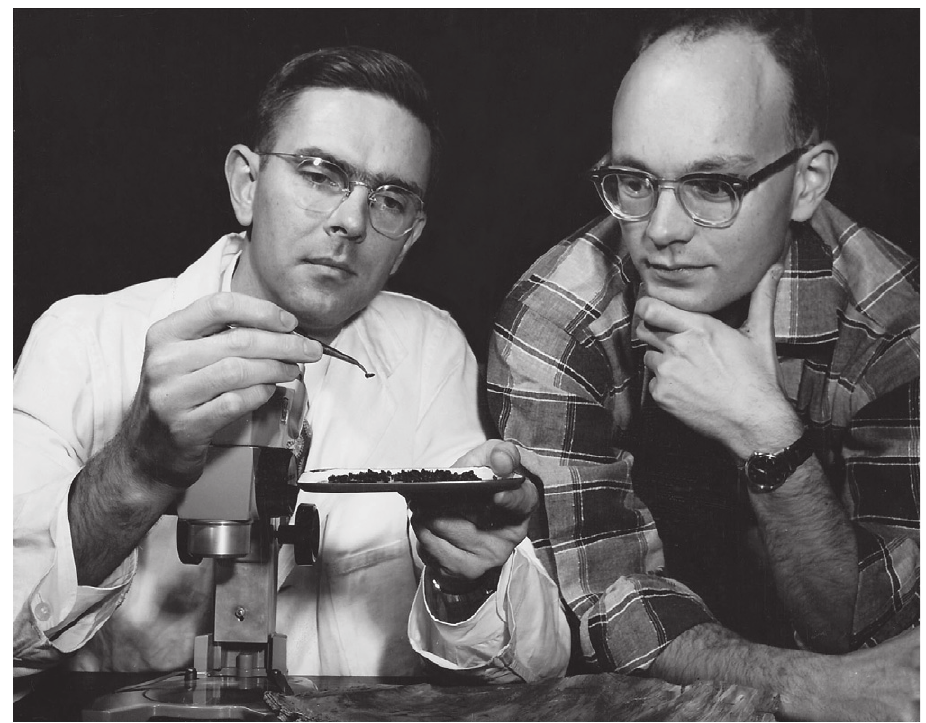
Figure 1. Steve Wood and his fi rst graduate student, Don Bright, checking some beetles,